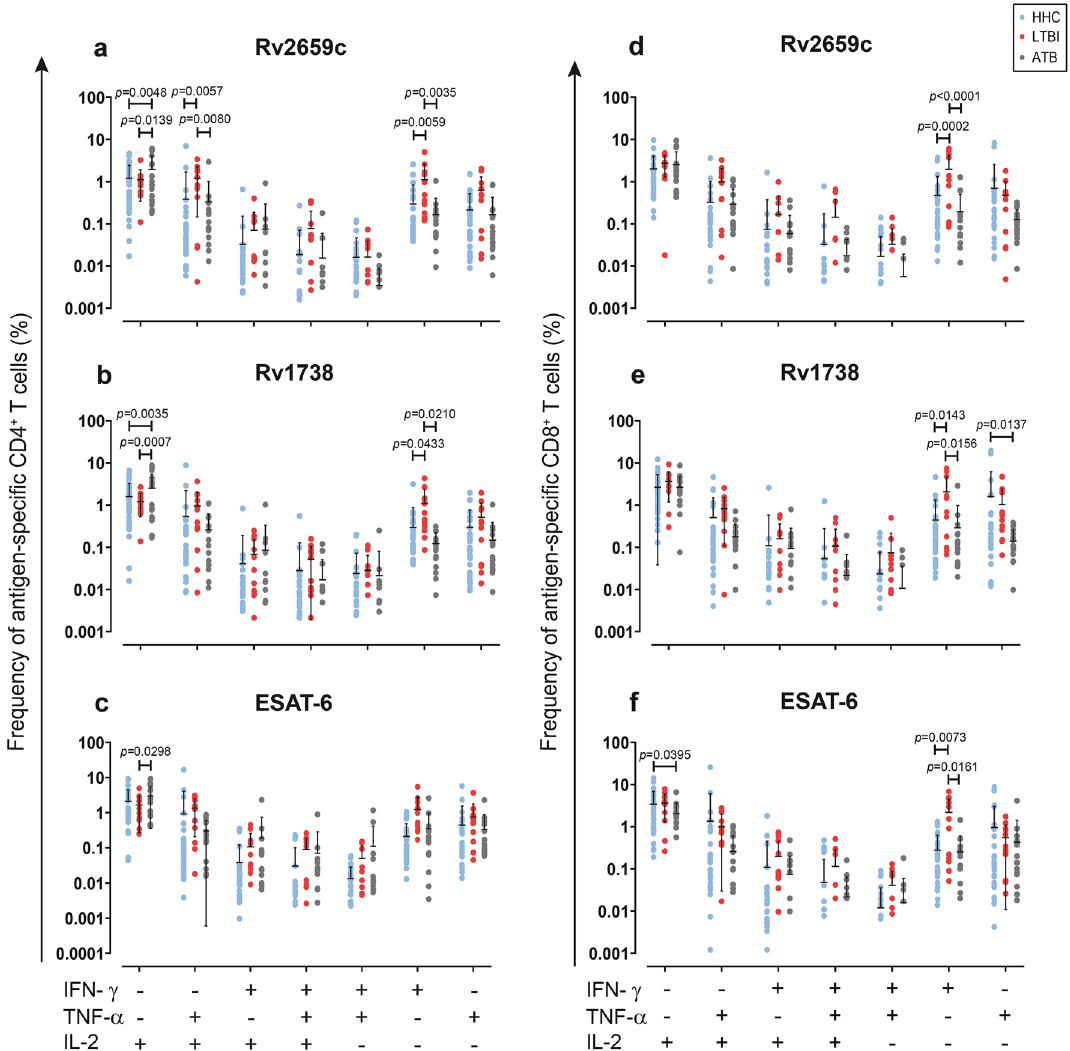
Figure 5. Intracellular cytokines specific CD4 + and CD8 + T cells upon stimulation with recombinant Rv2659c, Rv1738 and ESAT-6 proteins in HHC, LTBI and ATB subjects. PBMCs were stimulated with proteins Rv2659c ( a , d ), Rv1738 ( b , e ) or ESAT-6 ( c , f ) for 4 days. After stimulation, cells were harvested and stained for cell surface markers and intracellular cytokines as described in Materials and Methods. All possible combinations of the different functions are depicted on the X axis, whereas frequency of cytokine producing CD4 + and CD8 + T cells is depicted on the Y axis. Data were presented as mean ± SD. Two-way ANOVA following Sidak’s multiple comparisons test was performed; differences with p values < 0.05 were considered significant. Blue circles represent individuals with HHC (n = 30), red circles represent individuals with LTBI (n = 12) and grey circles represent individuals with ATB (n =